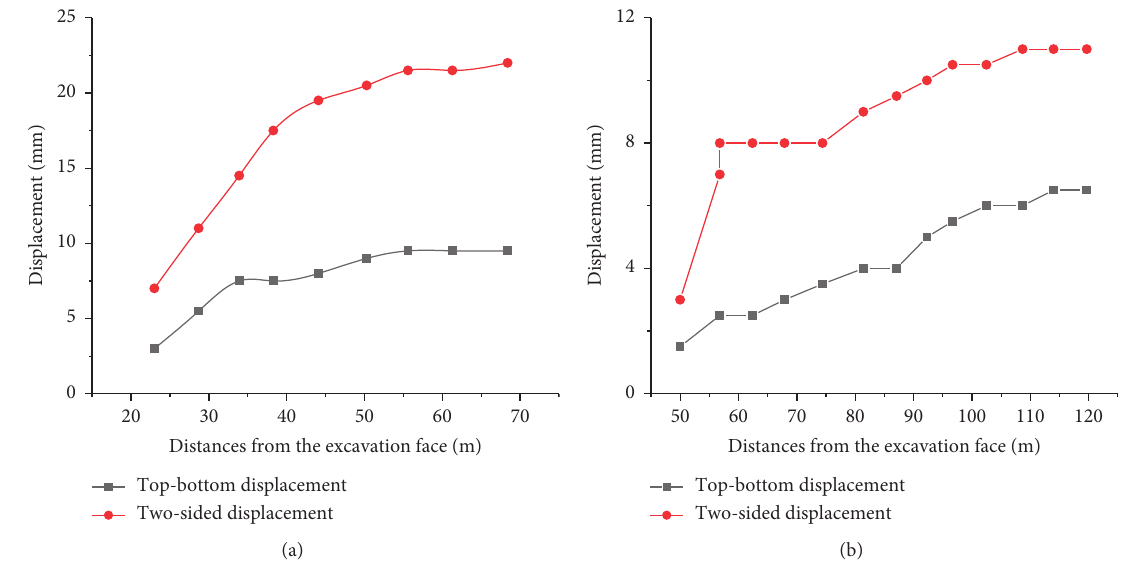
Figure 16: Roadway surface displacement. (a) 23m away from excavation face. (b) 50 m away from excavation